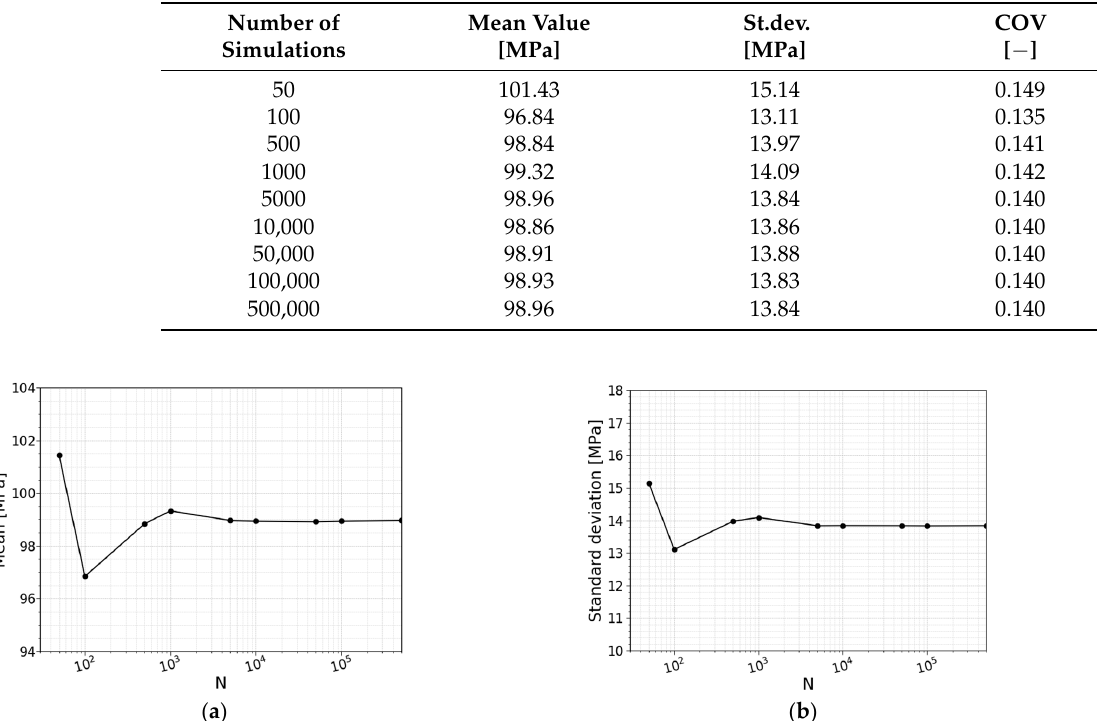
Table 2. Mean value, standard deviation and COV for varying numbers of simulations.